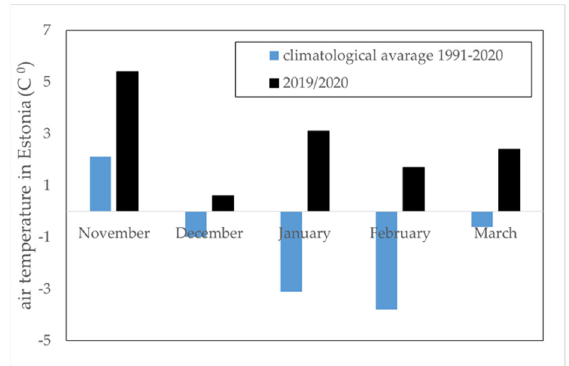
Figure 6. Meteorological data: monthly average air temperature (black) and corresponding climato- logical average (blue).